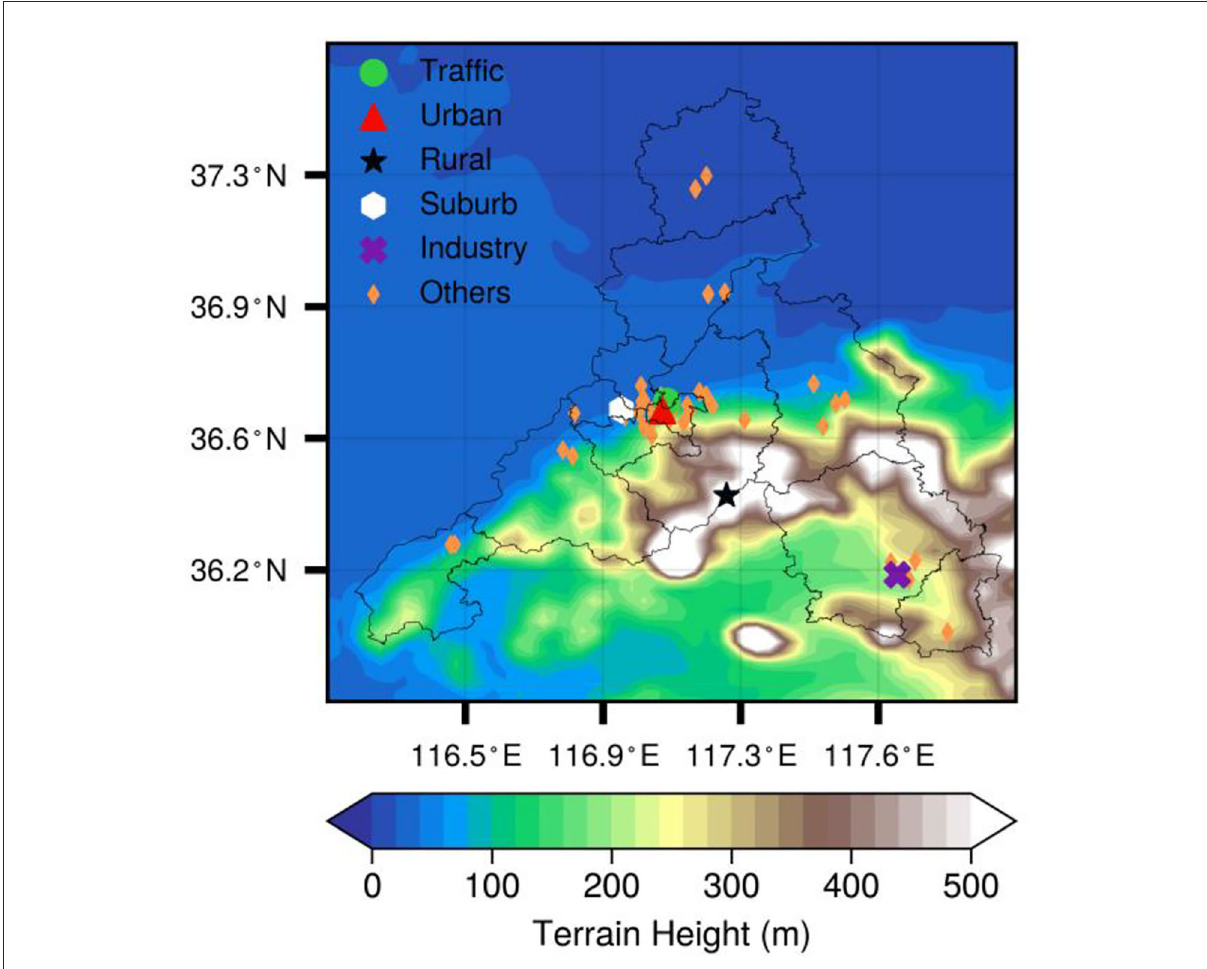
FIGURE1 Locations of ambient air quality monitoring stations in Jinan